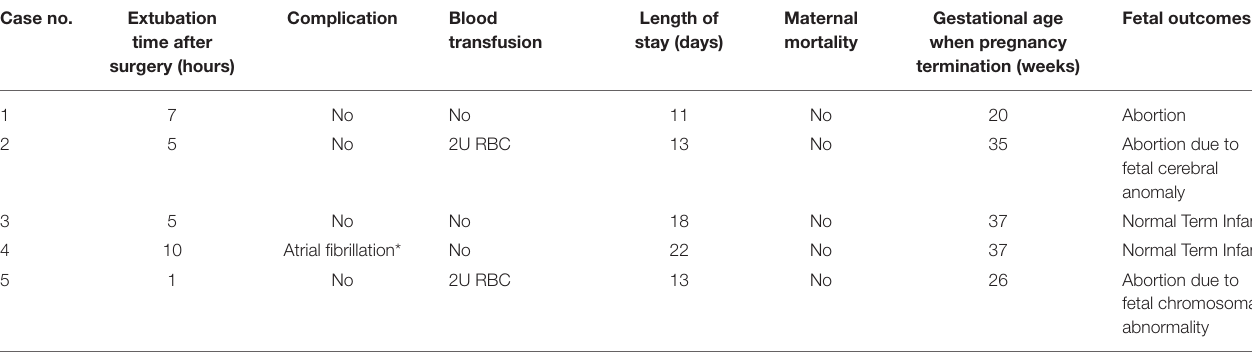
TABLE 3 | Postoperative information of five patients undergoing MICS during pregnancy. Case